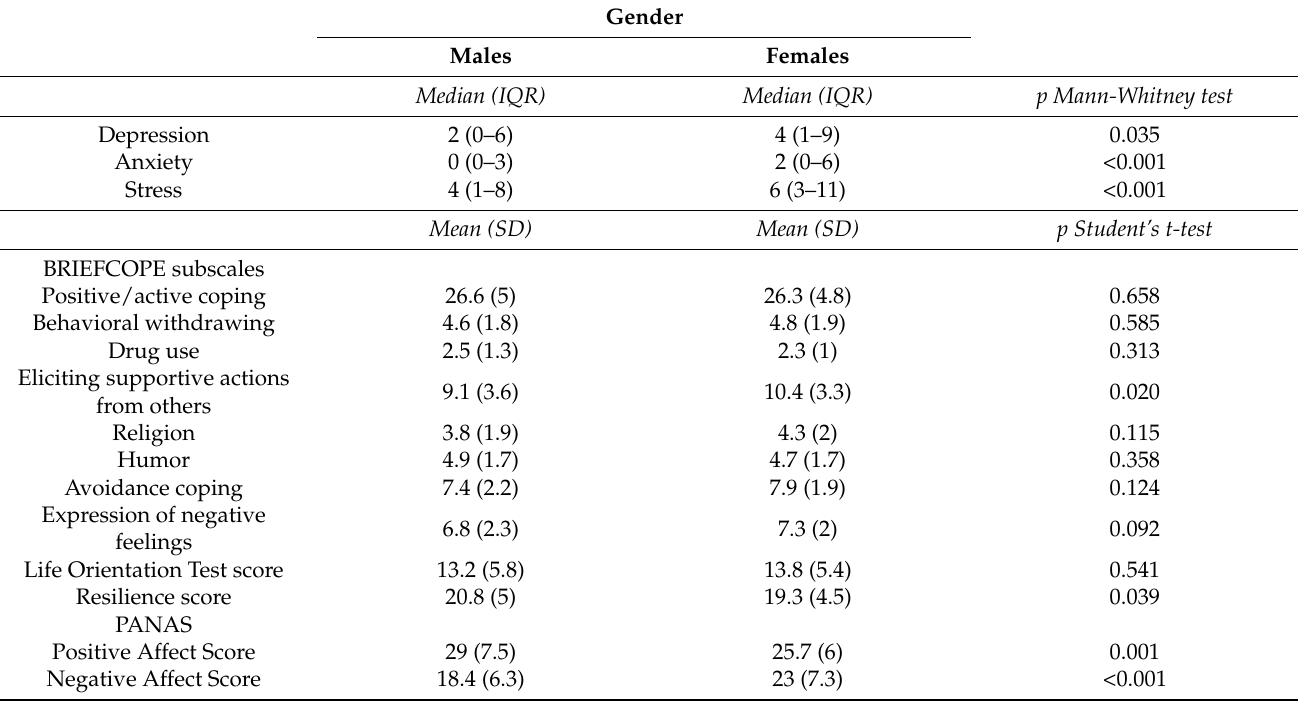
Table 4. Students’ scores by